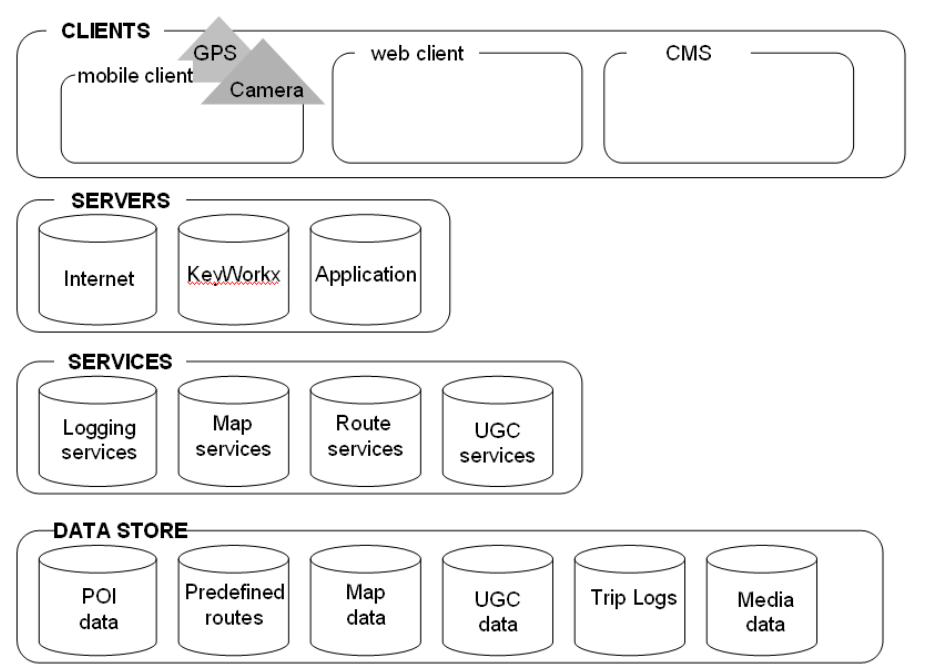
Figure 2. Digital Dowsing Rod